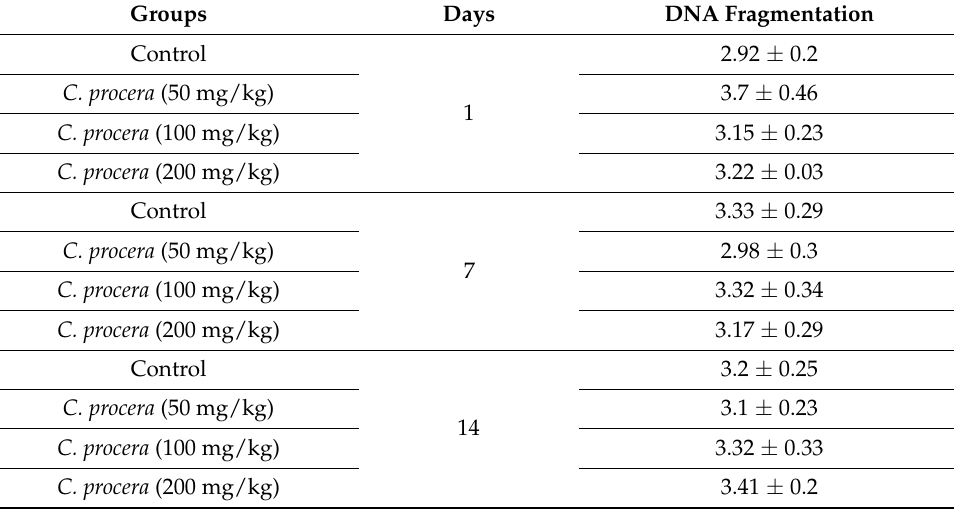
Table 6. DNA fragmentation in mouse liver cells after treatment with different doses of C. procera for 1, 7, and 14